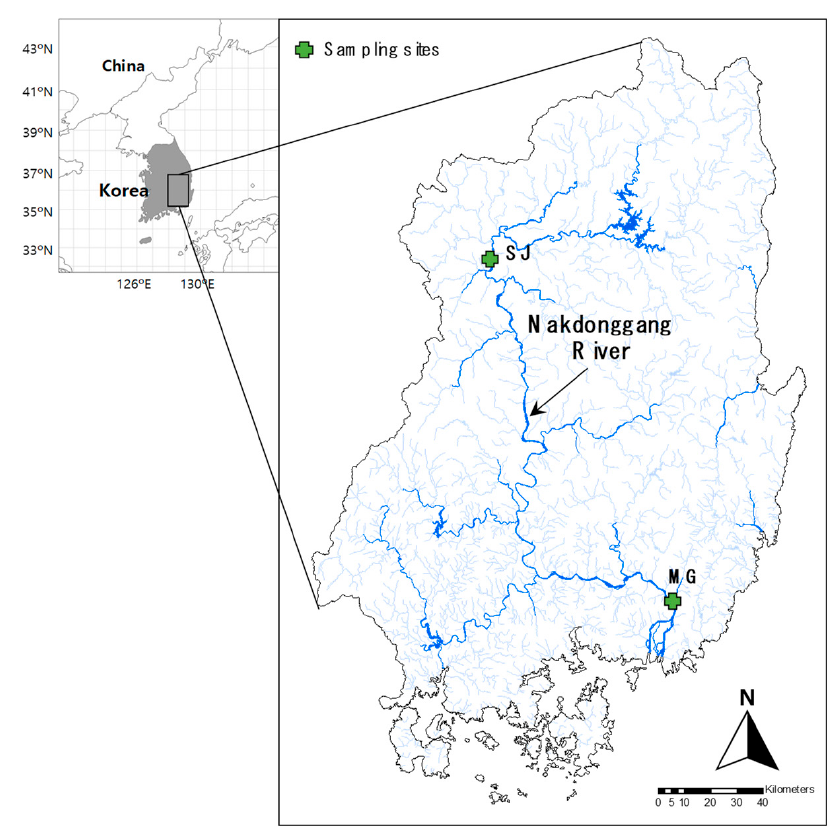
Figure 1. Location of the sampling sites (upstream of Sangju Weir, SJ; downstream of Changnyeong- Haman Weir, MG) in the Nakdonggang River, Korea.